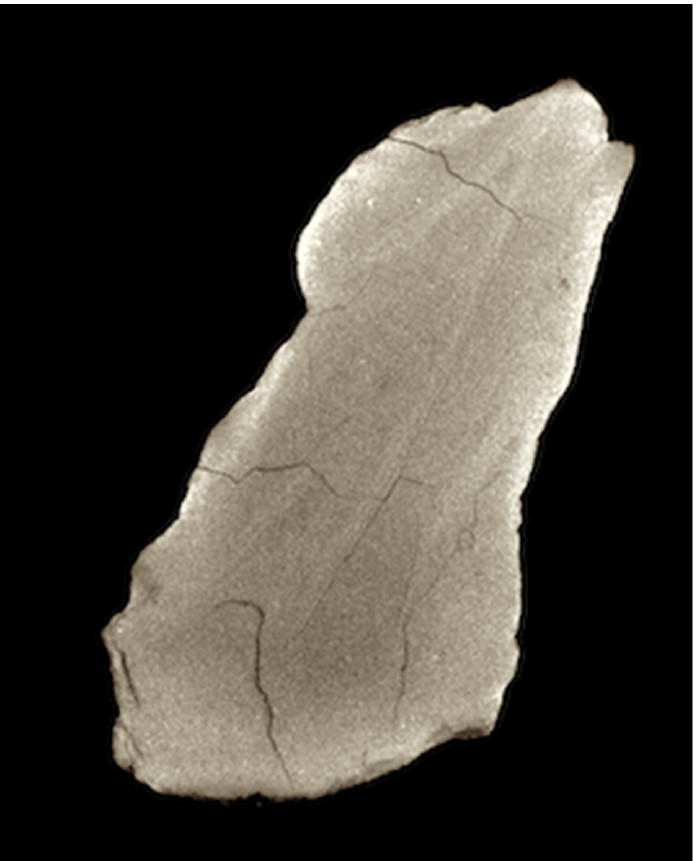
Figure 15. Micro-CT scan of specimen in previous image. Approximate sagittal section through specimen. The inverted V-shaped structure visible in the scan is interpreted here as a growth band that shows the sharp tip of the beak rostrum. For scale, see previous image.